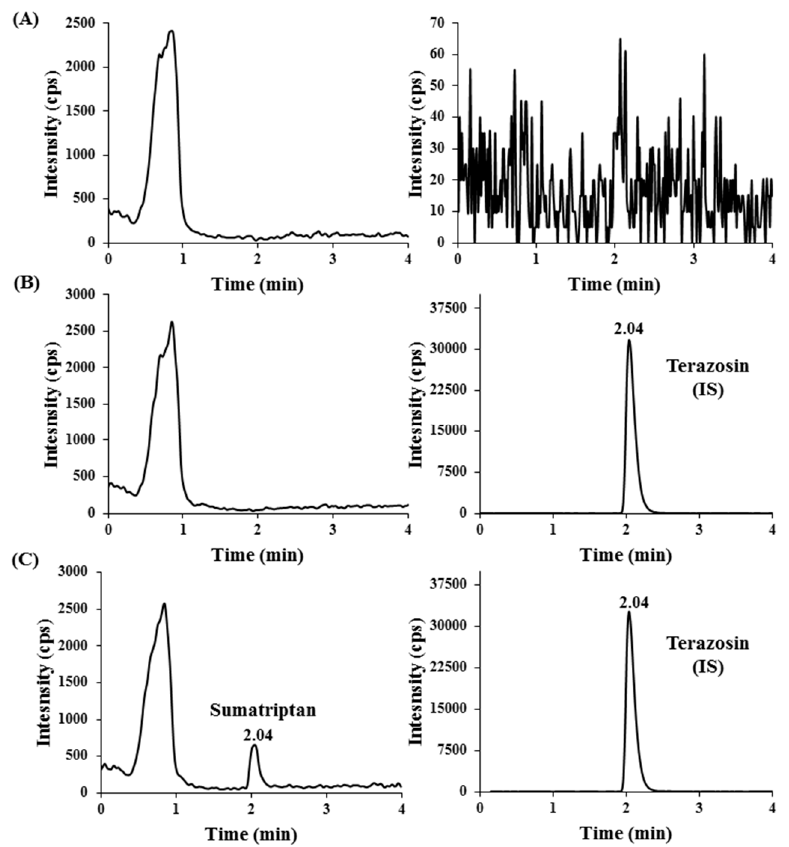
Figure 2. Representative chromatograms of ( A ) blank human plasma, ( B ) blank human plasma spiked with terazosin IS (41.3 ng / mL), and ( C ) human plasma spiked with Sumatriptan at the lower limit of quantification (LLOQ) (0.5 ng / mL) and terazosin IS (41.3 ng / mL). Left panel = sumatriptan; right panel = terazosin IS.